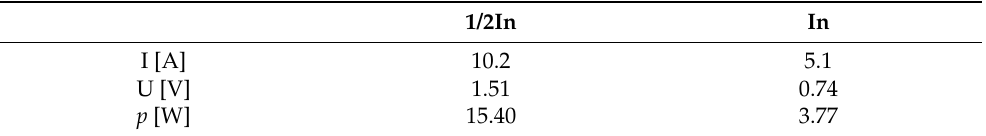
Table 6. Values obtained during measurement of the dissipated power in 10 A